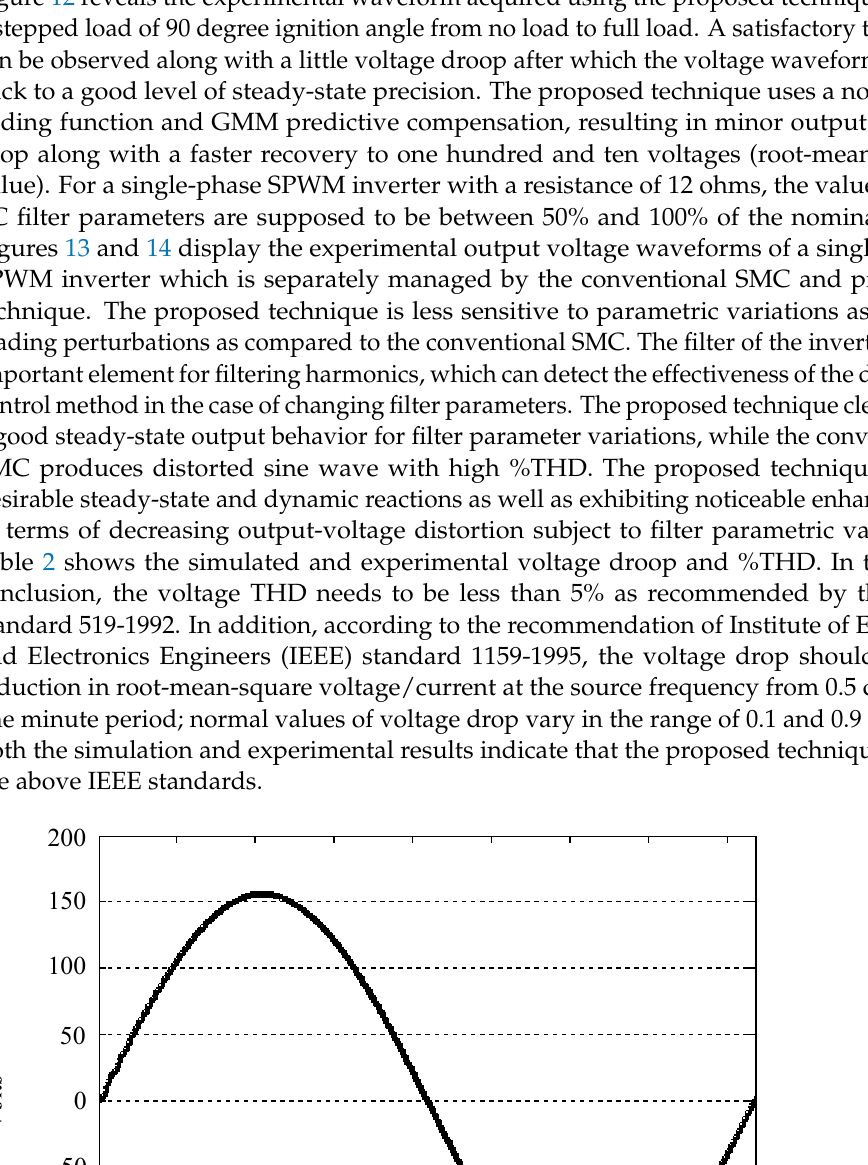
Figure 3. Simulated output voltage with the proposed technique under full load.